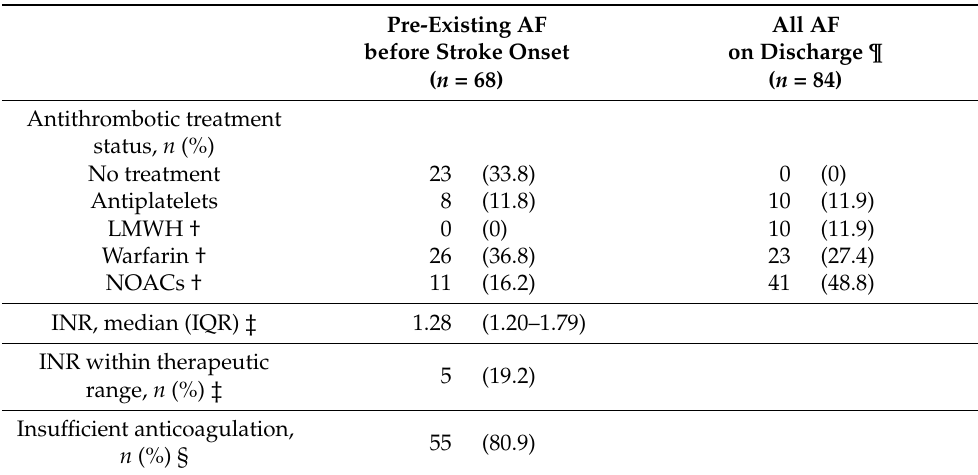
Table 2. Antithrombotic treatment status for stroke patients with pre-existing atrial fibrillation (AF) on admission and for all AF patients on discharge.